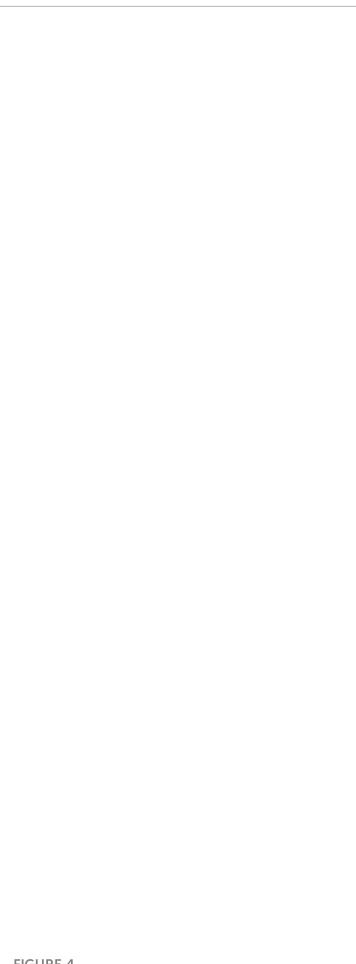
FIGURE 4 Model prediction results. (A) Comparison before and after optimization. (B) Predict model error